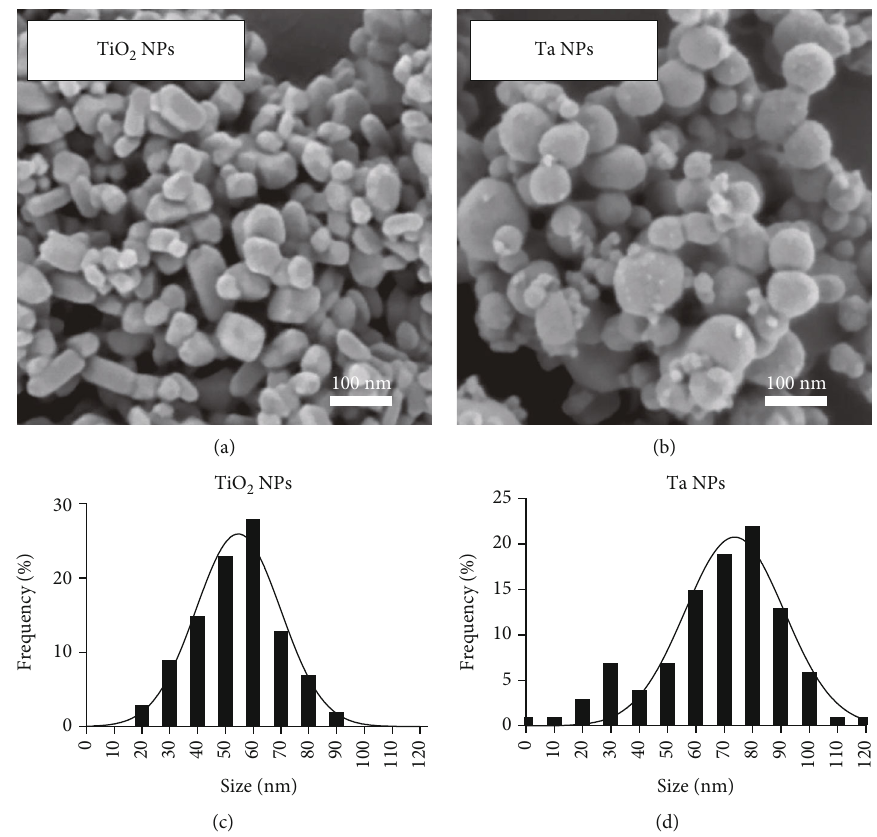
Figure 1: Characterization of TiO and Ta NPs. (a, b) Scanning electron microscopic (SEM) images of TiO 2 size distribution with Gaussian fi tting of TiO NPs and Ta NPs was determined by randomly selecting 100 particles from the SEM images. 2